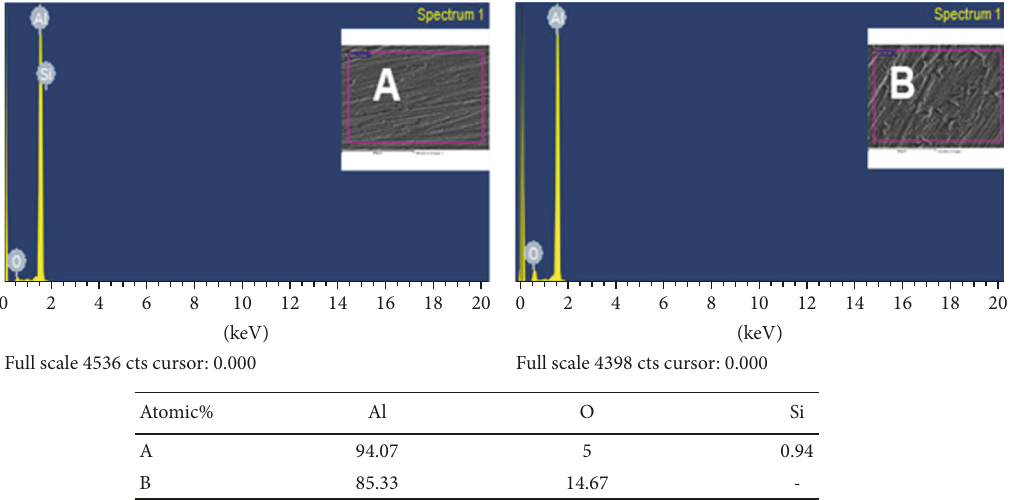
Figure 16: EDS results of Al 6061 “A” before and “B” after being immersed in the Red Sea water for 5